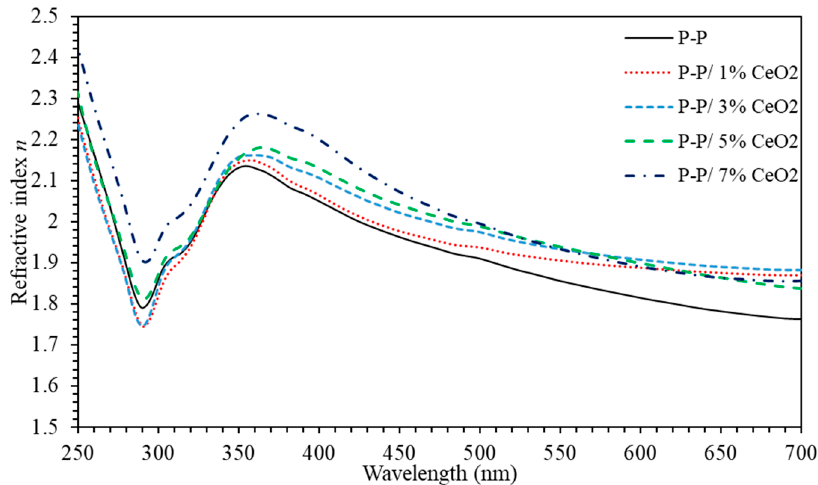
Figure 4. The refractive index ( n ) of (PMMA-PS)/CeO 2 nanocomposite thin films with various CeO 2 NPs